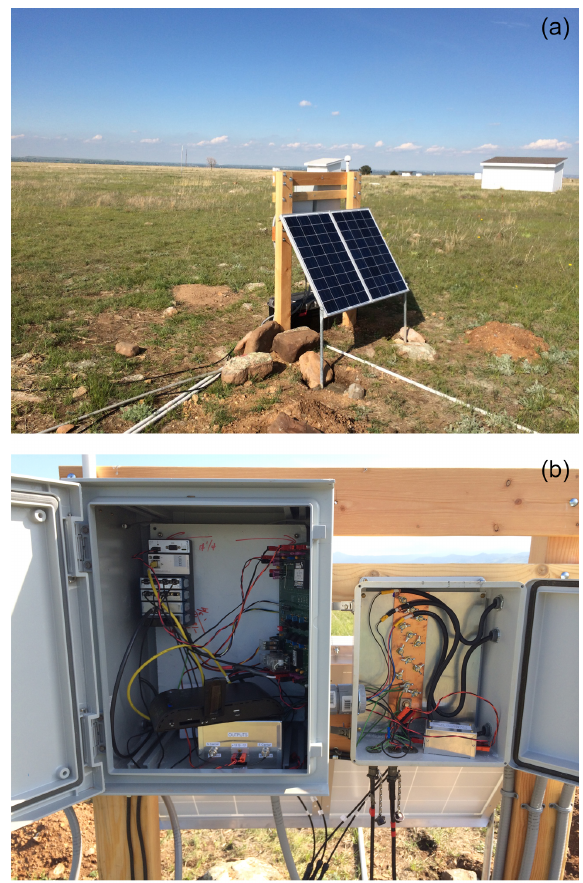
Figure 4. Geoelectric field data acquisition system at the Boulder observatory. (a) View to the northeast of the data acquisition sys- tem. Electric field lines, protected by PVC conduit, extend west and south. (b) Interior view of data acquisition system in environmen- tally sealed enclosures. Electric and optionally magnetic inputs are brought into the right enclosure with shielding tied to the observa- tory grounding system. The left enclosure containing the ObsRIO is in the upper left, the switching power-source controller is on the right, and a cellular model in the